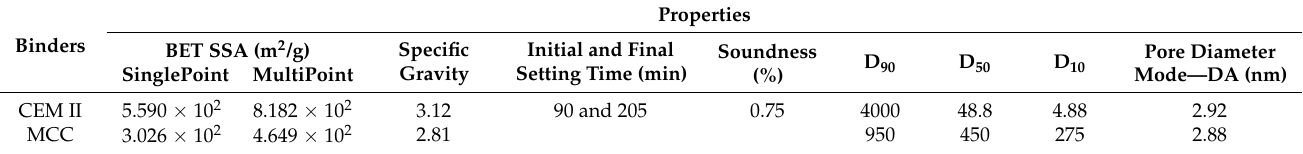
Figure 2. Particle size distribution of MCC and CEM II. Table 3. Physical properties of CEM II and